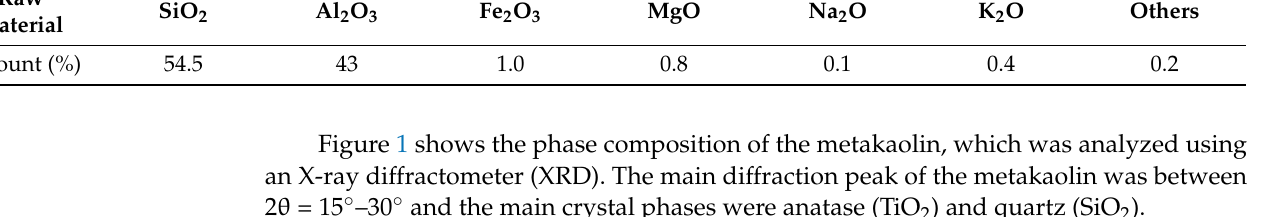
Table 1. The chemical components of metakaolin (mass fractions).